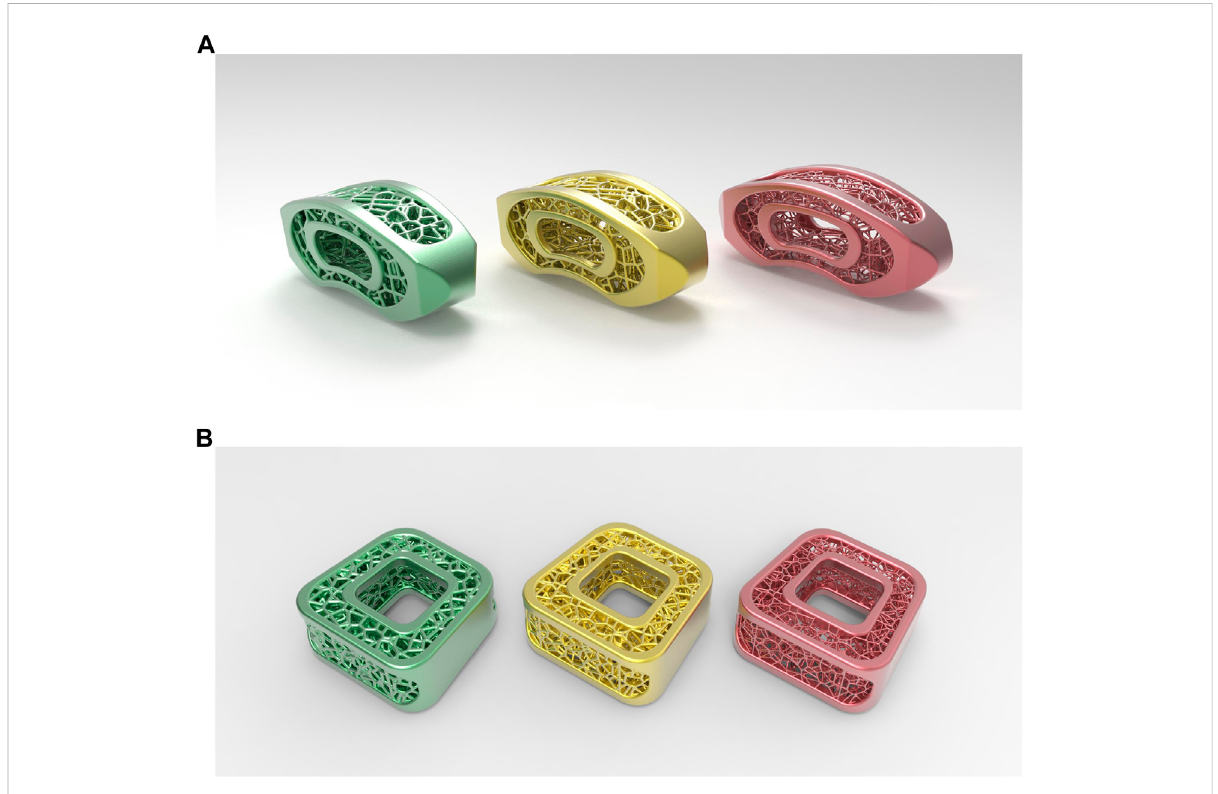
FIGURE 2 High-to-low endplate vBMD cages for lumbar (A) and cervical (B)